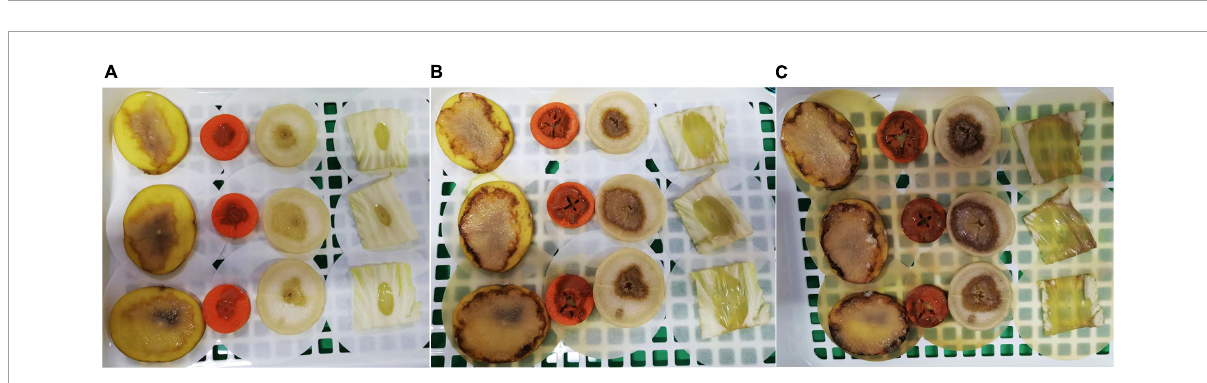
FIGURE9 Pathogenicity of Dickeya zeae strain WH1 on potato tubers, carrot, radish, and Chinese cabbage. (A) Infected for 24 h; (B) infected for 48 h; (C) infected for 72